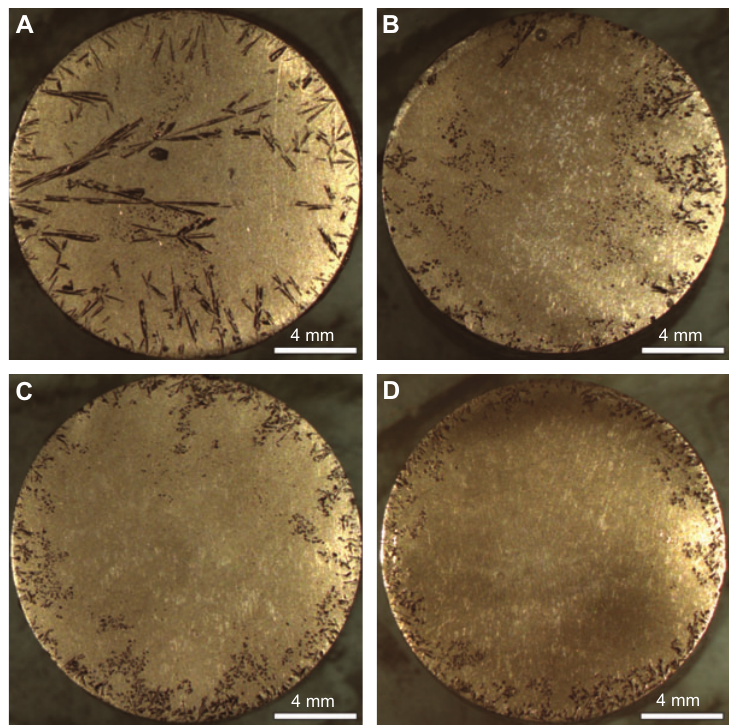
Figure 2 The transverse macrostructure of the samples as observed by stereoscopy in Al-22.9 wt. % Si alloy (A) without TMF; (B) with TMF